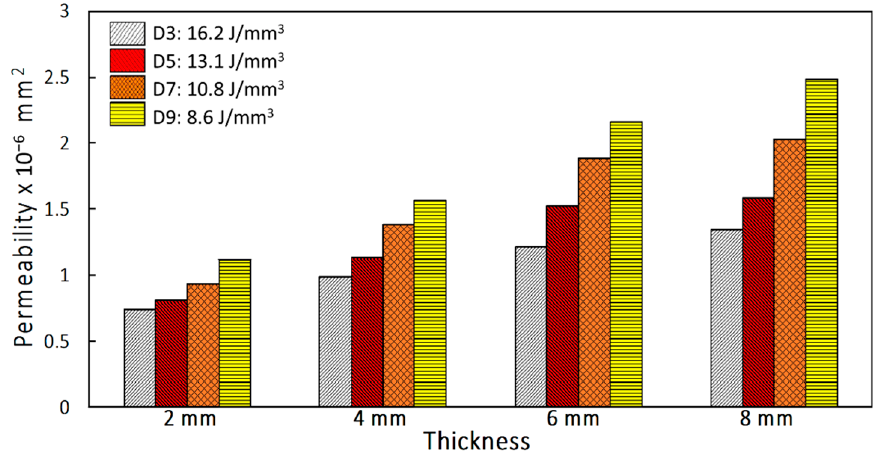
Figure 11. Permeability as a function of energy density (J/mm 3 ) and coupon thickness at inlet pressure of 0.14 MPa.